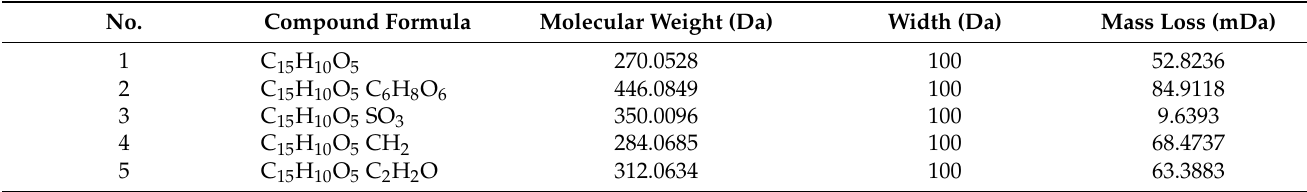
Table 1. Establishment of quality loss template.